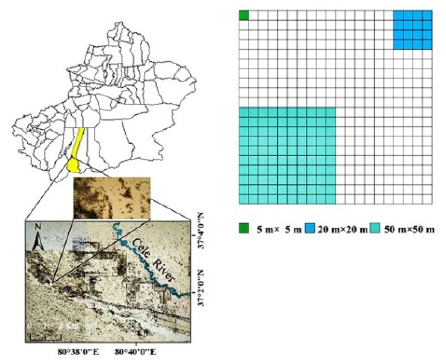
Figure 1. Location of the study area and the investigated plots.